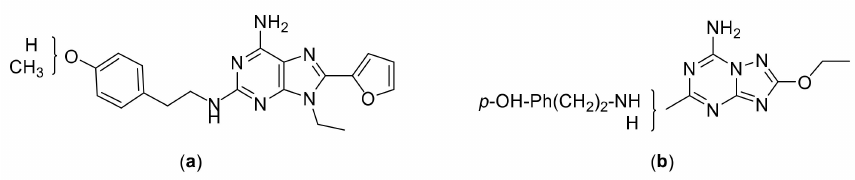
Figure 2. Structures of the designed compounds: ( a ) purine derivatives; ( b ) triazolotriazine